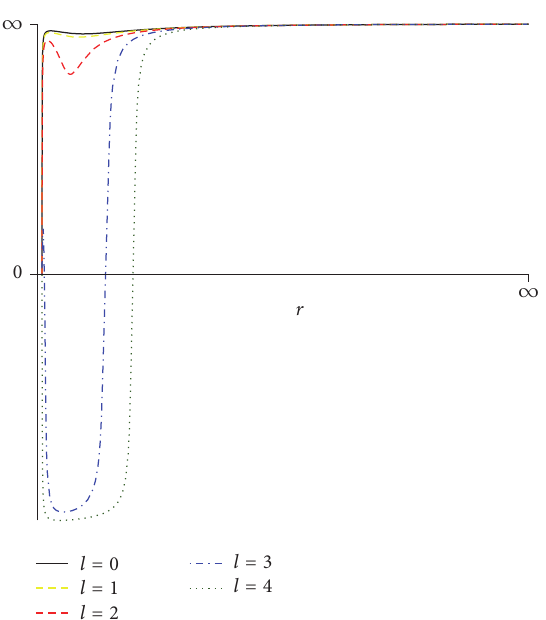
Figure 5: The potential 𝑉 in function of the tortoise coordinates for the fixed values of 𝛼 0 = 2 , 𝑀 = 1 , and 𝜇 = 0 .